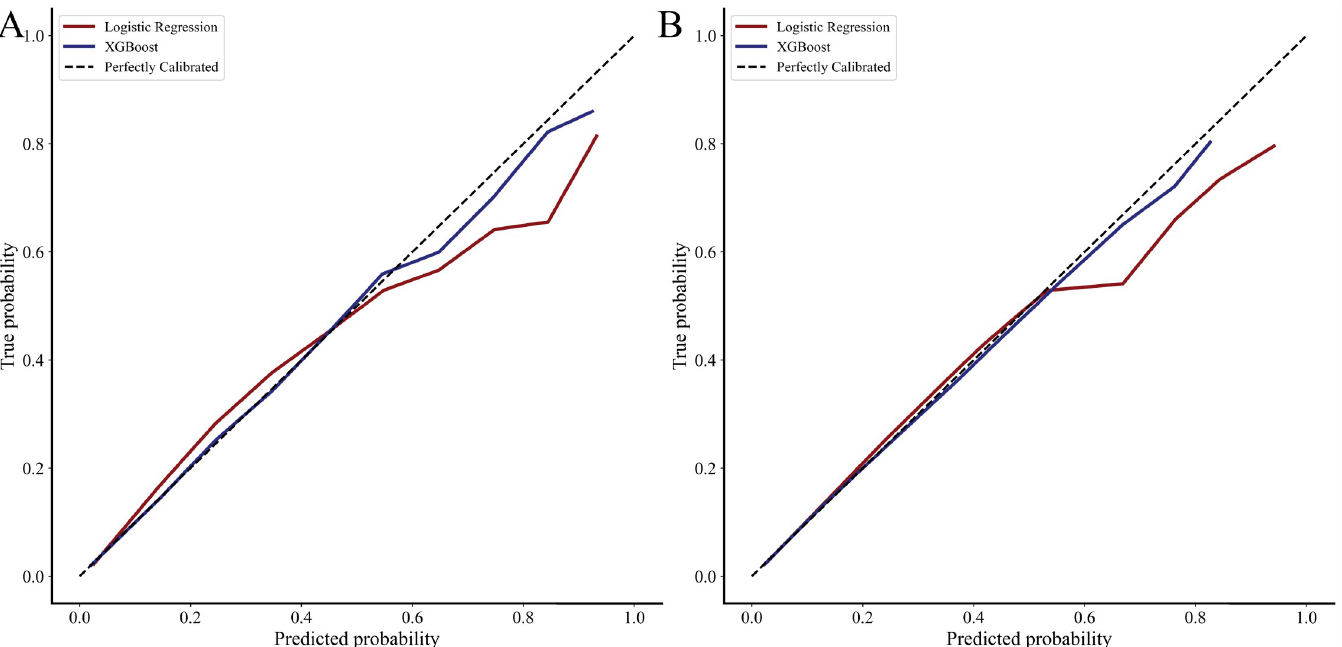
Fig 3. Calibration curves for logistic regression and XGBoost for complete (3A) and sparse (3B) feature sets. Complete set refers to the inclusion of all covariates in model development, while sparse set refers to the inclusion of 3 comorbidities (congestive heart failure, neurologic disorder, coagulopathy) and 6 emergency general surgery operative